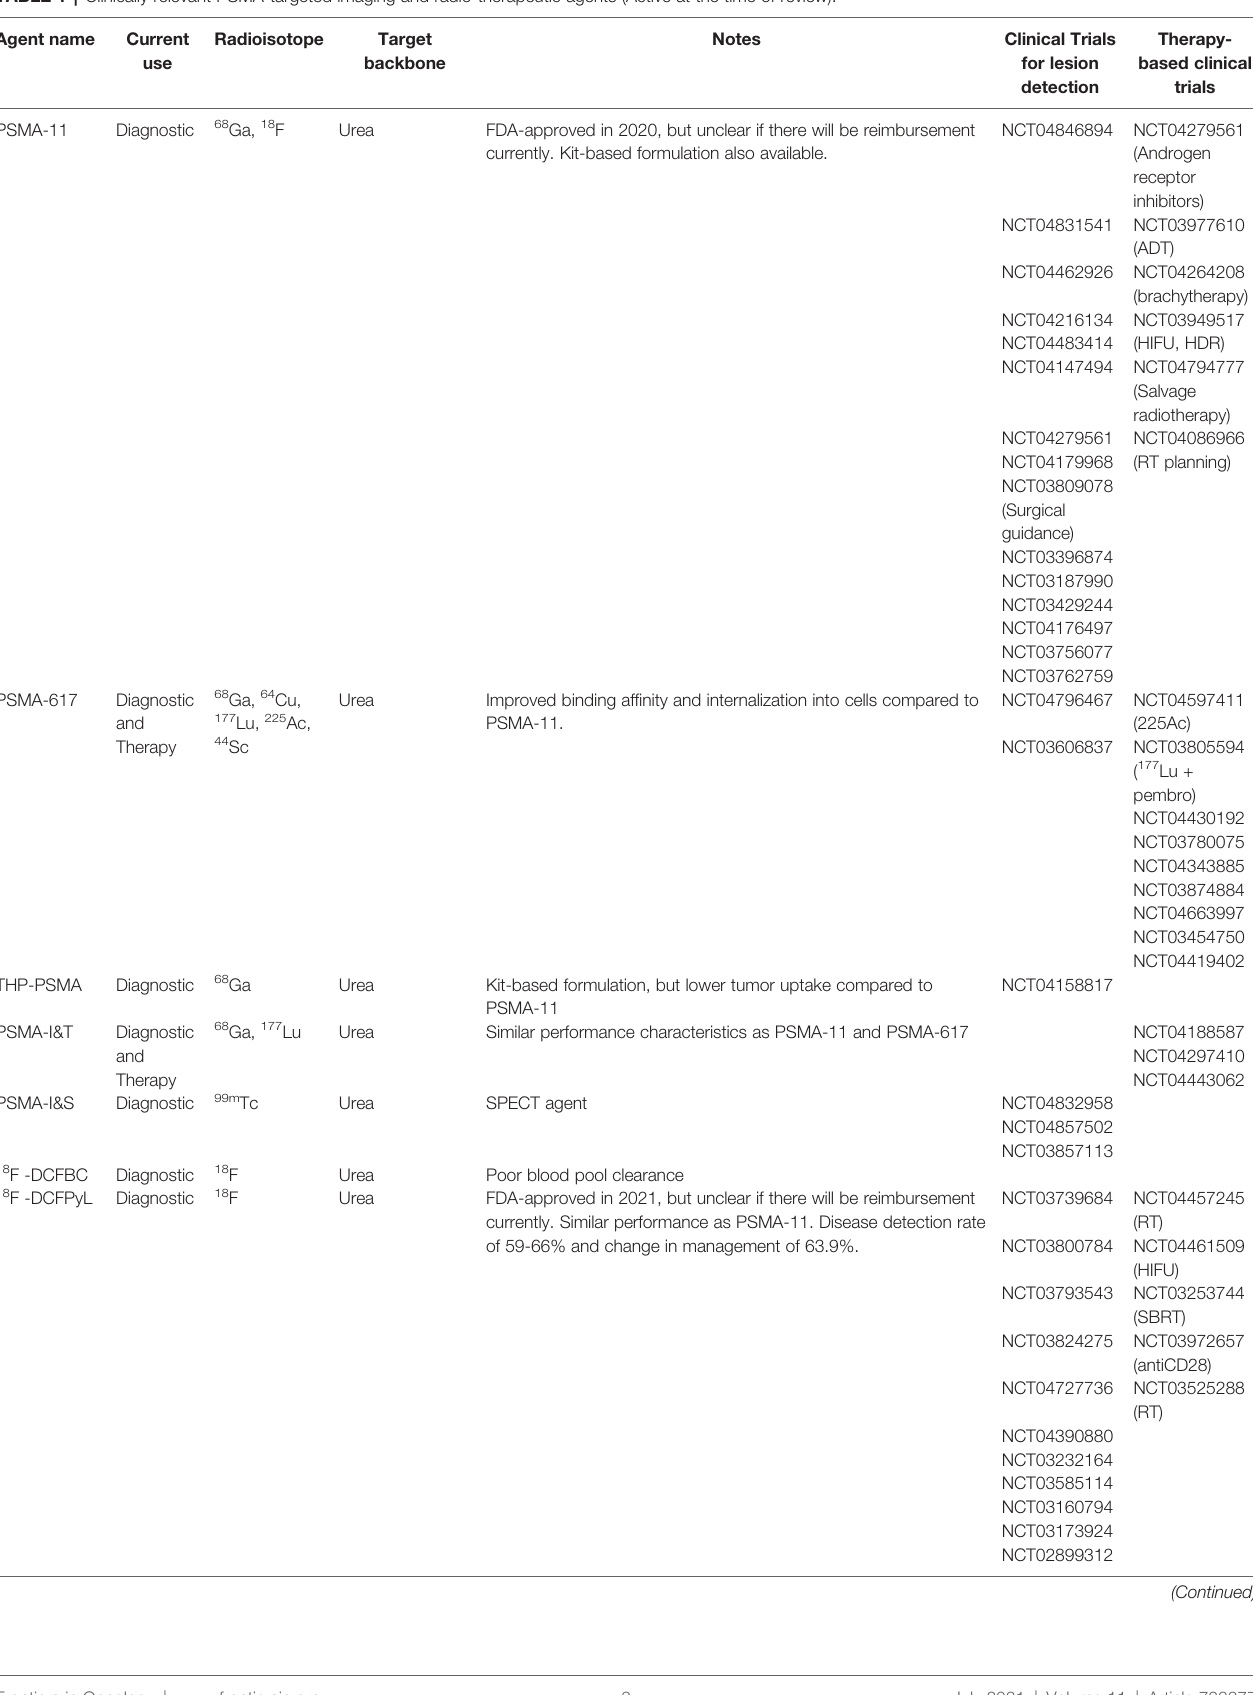
TABLE 1 | Clinically relevant PSMA-targeted imaging and radio-therapeutic agents (Active at the time of